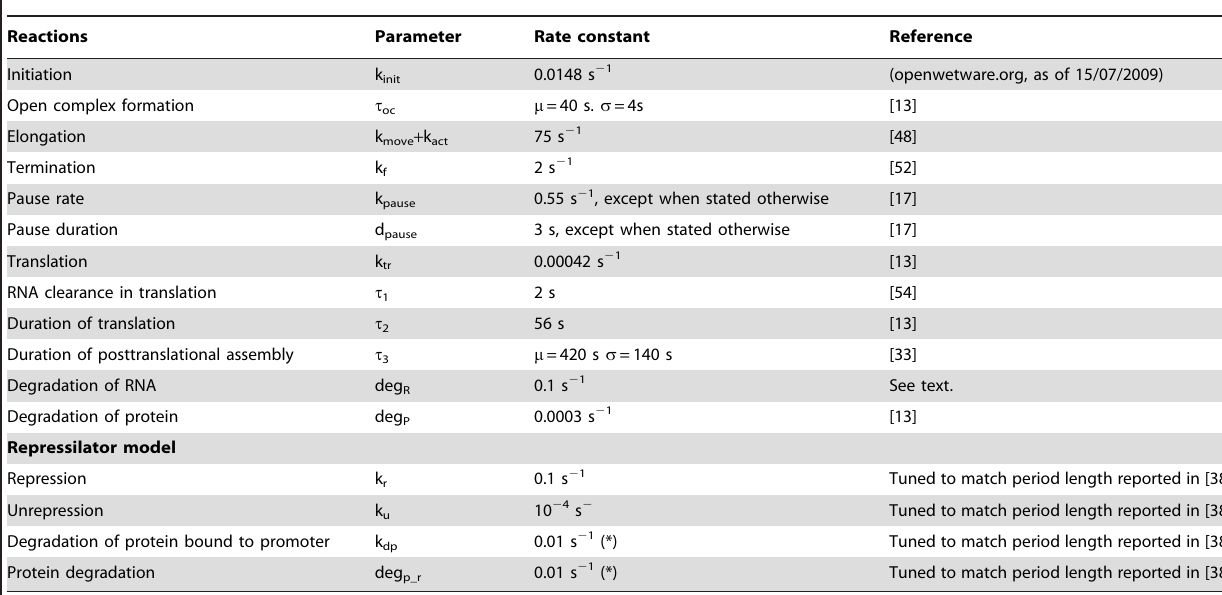
Table 2. Values of the rate constants used in